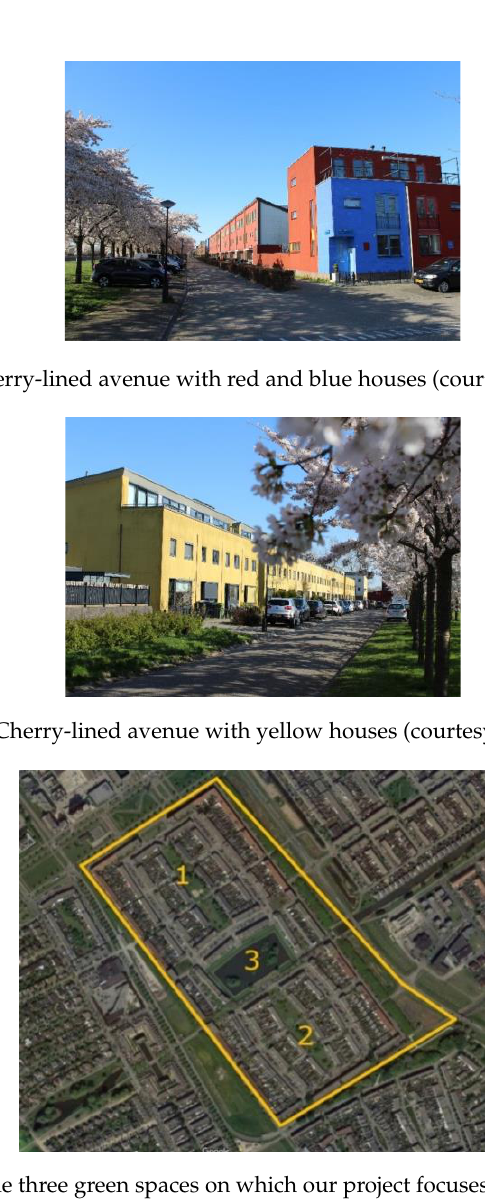
Figure 5. Green space in Regenboogbuurt: Location 1 (courtesy of Author 2).